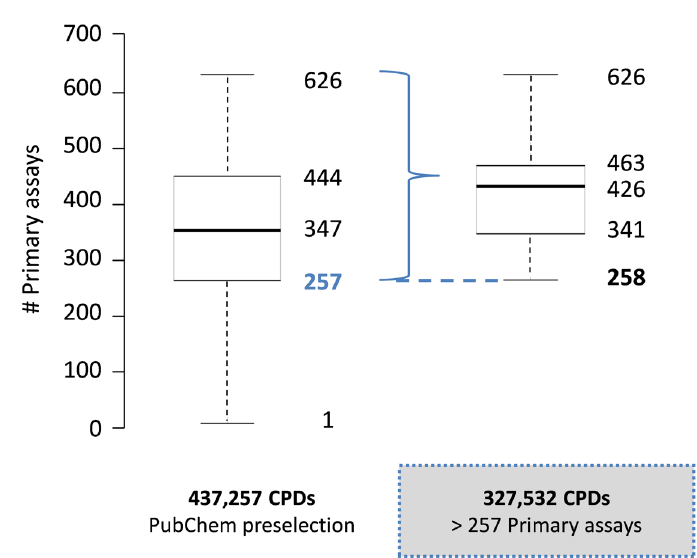
Figure 1. Assay frequency distribution. The frequency distribution of primary assays is shown in a boxplot format for 437,257 pre-selected PubChem compounds and a subset of 327,532 compounds. The plot gives the smallest number of primary assays (lower whisker), first quartile (lower boundary of the box), median value (thick line), third quartile (upper boundary of the box), and largest number of assays (upper whisker). Outliers are not displayed. The dashed blue line indicates the selection criterion for the compound subset (i.e., tested in more than 257 primary